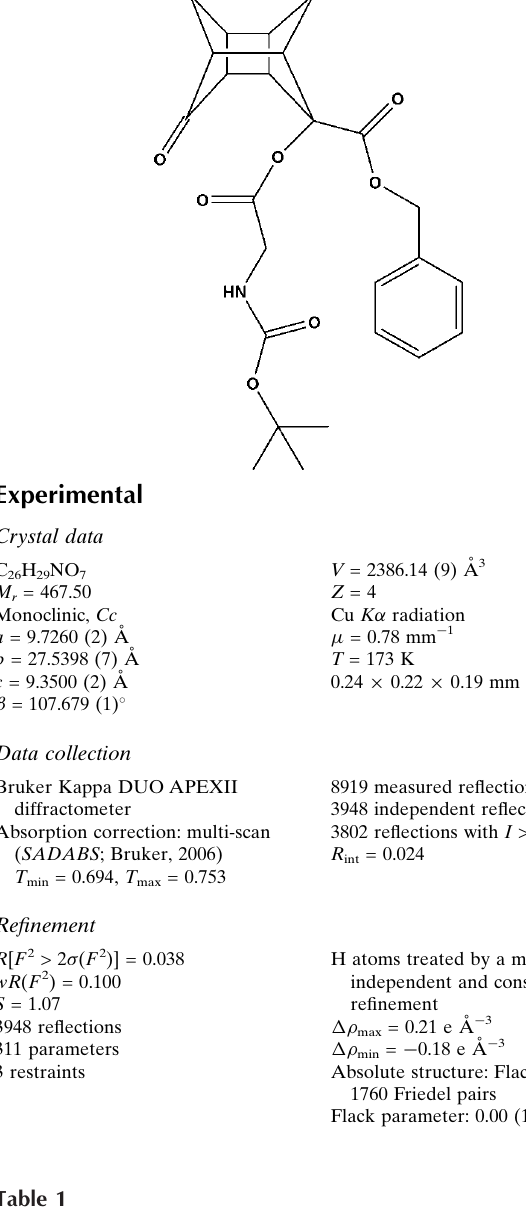
Hydrogen-bond geometry (A˚ , (cid:3)